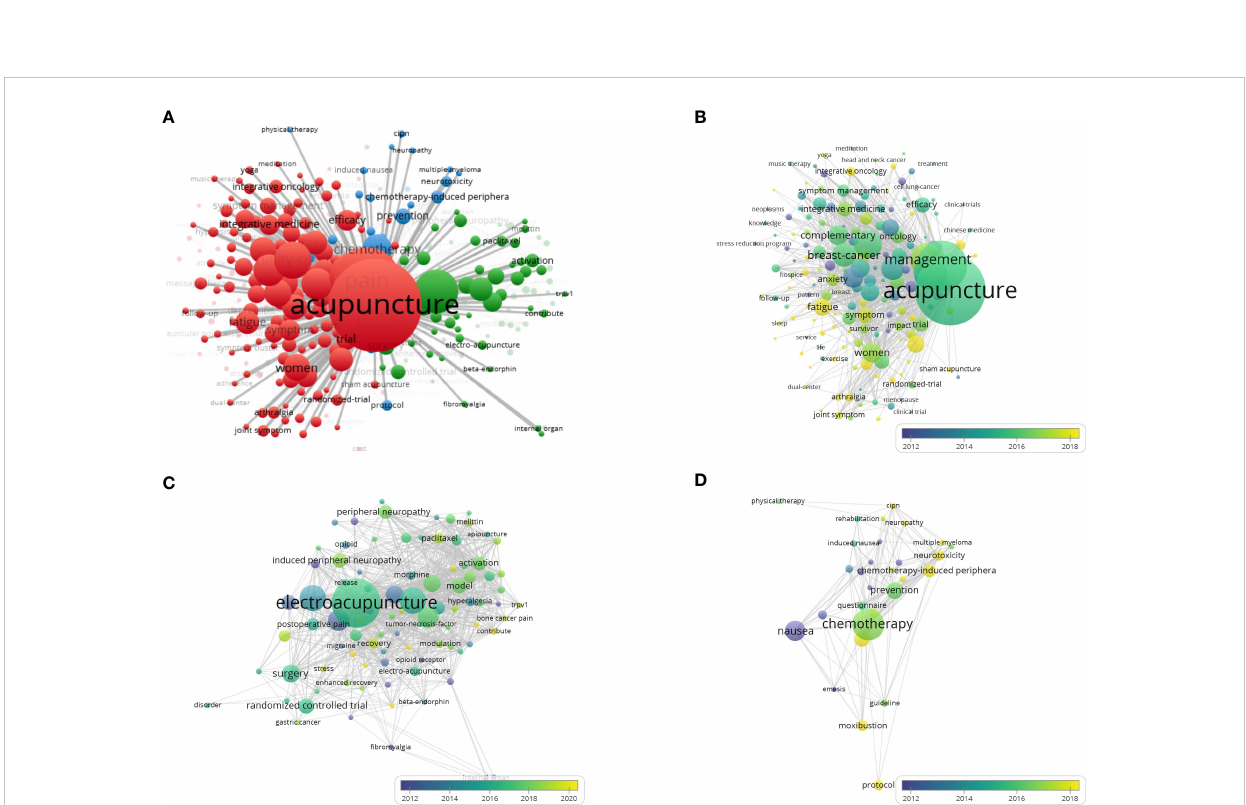
FIGURE 8 Co-occurrence analysis of keywords of research on acupuncture for cancer pain. (A) Mapping of predominant keywords of research. Footnote: The keywords were classi fi ed into 3 clusters, presented by three colors (red, green, and blue). (B – D) Overlay visualization of red cluster keywords, green cluster keywords, and blue cluster keywords by time (blue: earlier, yellow: later).